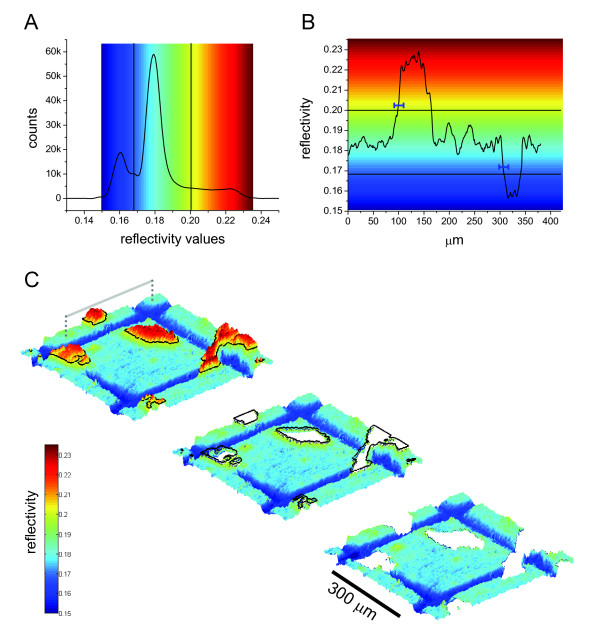
Illustration of the image analysis procedure to quantify protein deposition at cell edge. A) A histogram of image reflectivity pseudocolored with the colorbar scale shown is divided into three distinct regions: PEG-thiol (dark blue), fibronectin/protein (light blue-green), and cell features (yellow-red). B) A line that spans the regions of cell contact, fibronectin/protein layer, and PEG-thiol layer is shown as the grey bar in (C) and the reflectivity values under that line is shown in (B). The horizontal blue bars mark the width of the transition (average 5 μm to 8 μm) from one region to the other. C) Sequential image analysis steps for a SPR topographic image of a 300 μm square fibronectin island where the z-axis corresponding to reflectivity values shown in the colorbar. The first image shows the cell, protein, and PEG-thiol regions with a black ring segmenting the cell-protein threshold, at a reflectivity value of 0.20, as displayed in (A) and (B). The second image deletes the cell objects and the black line highlights the initial cell contour ring that still borders part of the cell edge as seen in (B). The third image dilates the cell contour by 5 pixels clearing the cell-protein transition region as shown in (B). It is at this point that sequential contour dilating to determine surface protein coverage surrounding cells is begun. The black scale bar equals 300 μm, and the gray bar corresponds to the line scan used in (B).